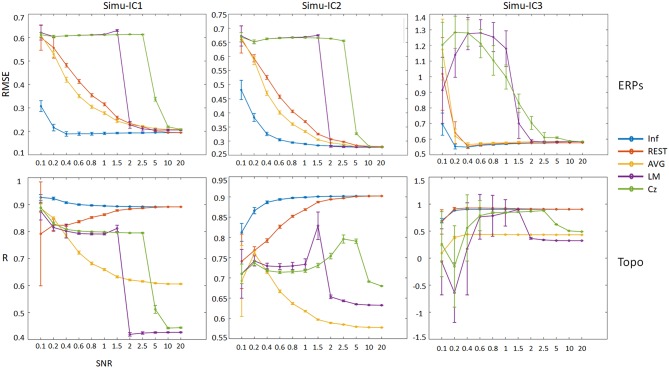
Performances of ICA time courses and topographies with different references (Inf, REST, AVG, LM, and Cz) using a range of SNRs from 0.1 to 20. The vertical axis of the first row is the mean RMSE (with standard deviation) between true noiseless ERPs and ICA-extracted ERPs with a reference, and the vertical axis of the second row is the mean spatial correlation (with standard deviation) between true topographies and ICA-extracted topographies with a reference. Columns from left to right correspond to the ICA components (Simu-IC1, Simu-IC2, and Simu-IC3), and the horizontal axis is the SNR.